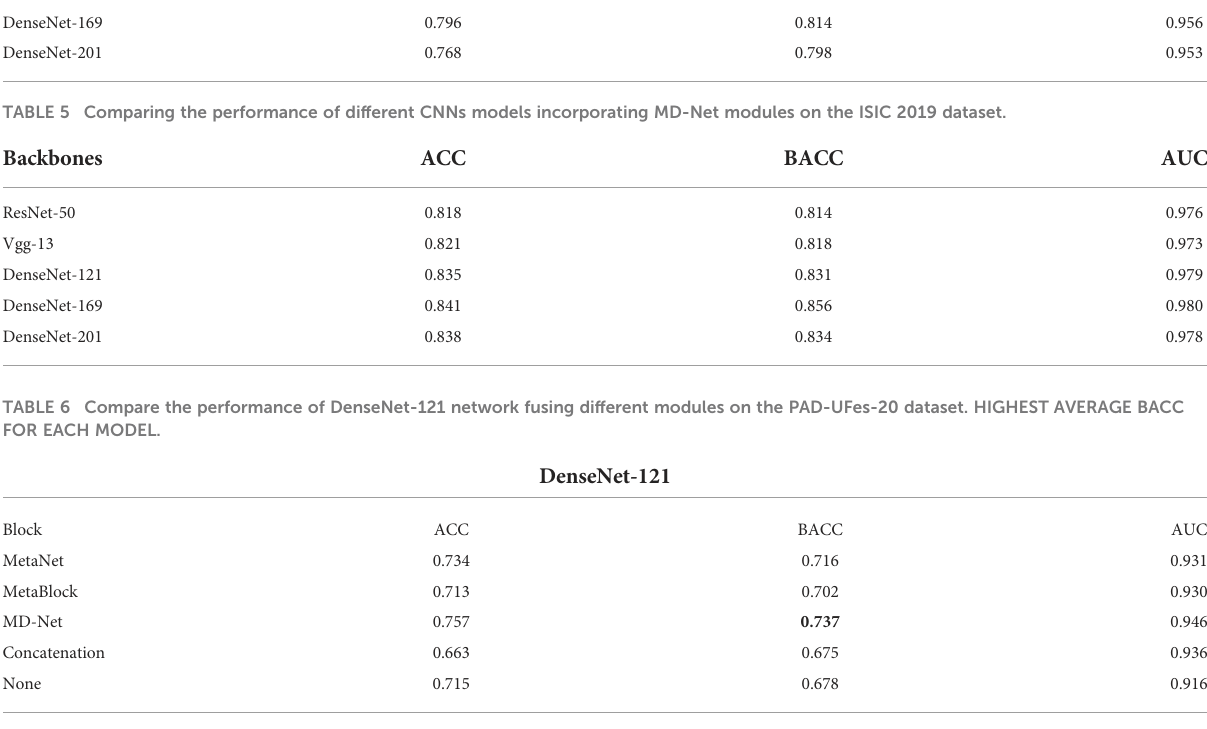
TABLE 7 Compare the performance of DenseNet-169 network fusing different modules on the PAD-UFes-20 dataset. HIGHEST AVERAGE BACC FOR EACH MODEL.